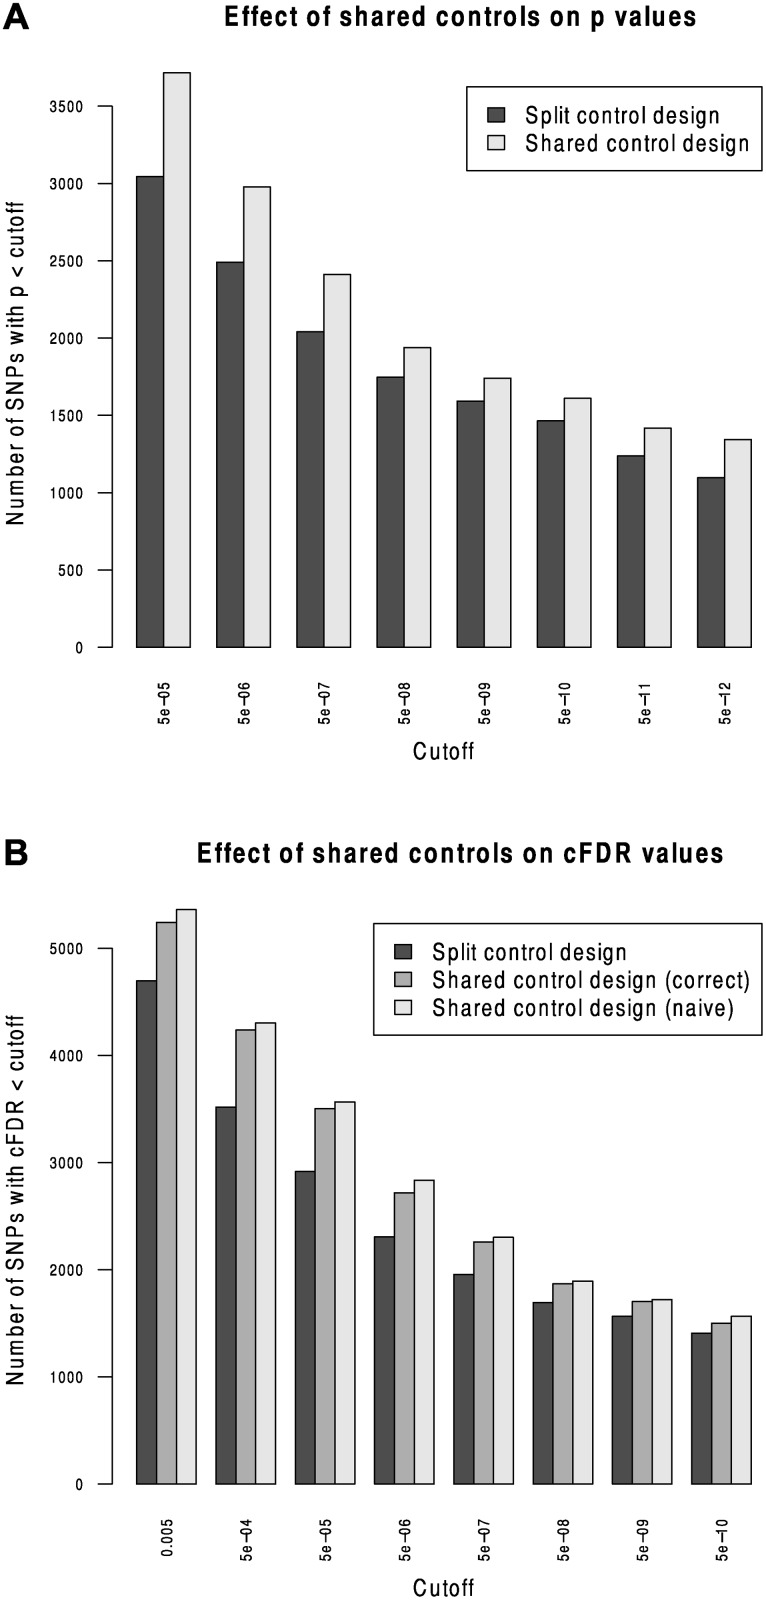
Validation of the shared-control approach and the p-value adjustment due to shared controls.Panel A shows the effect of splitting controls on power to detect association. The number of SNPs with p values less than a given cutoff are shown for split-control and shared-control approaches. For all p-value cutoffs, fewer SNPs reach significance when using a split-control design. Panel B shows the number of SNPs with cFDR^ values less than a given cutoff using the existing method on a split-control design, our extended method on a shared control design with the adjustment for shared controls, or using the split-control approach naively on the shared-control design; that is, assuming incorrectly that Pr(Pi≤pi∣Pj≤pj,H0(i))=pi. The second figure shows that failing to correctly calculate Pr(Pi≤pi∣Pj≤pj,H0(i)) leads to a subtle increase in the number of SNPs declared non-null at all cutoffs, due to the incorrect underestimation of cFDR^.